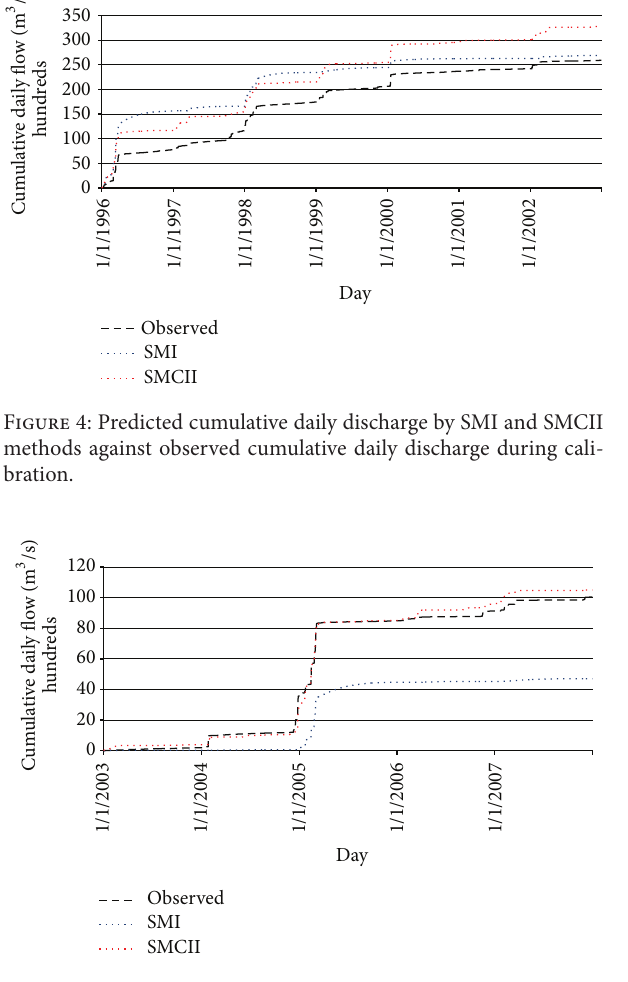
Figure 5: Predicted cumulative daily discharge by SMI and SMCII methods against observed cumulative daily discharge during valida- tion.